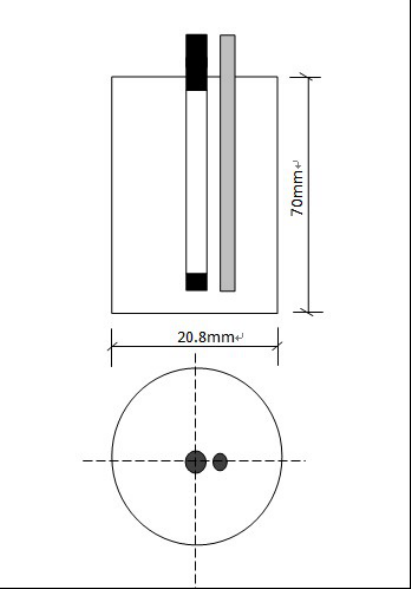
Figure 3: Dimensions of corrosion test